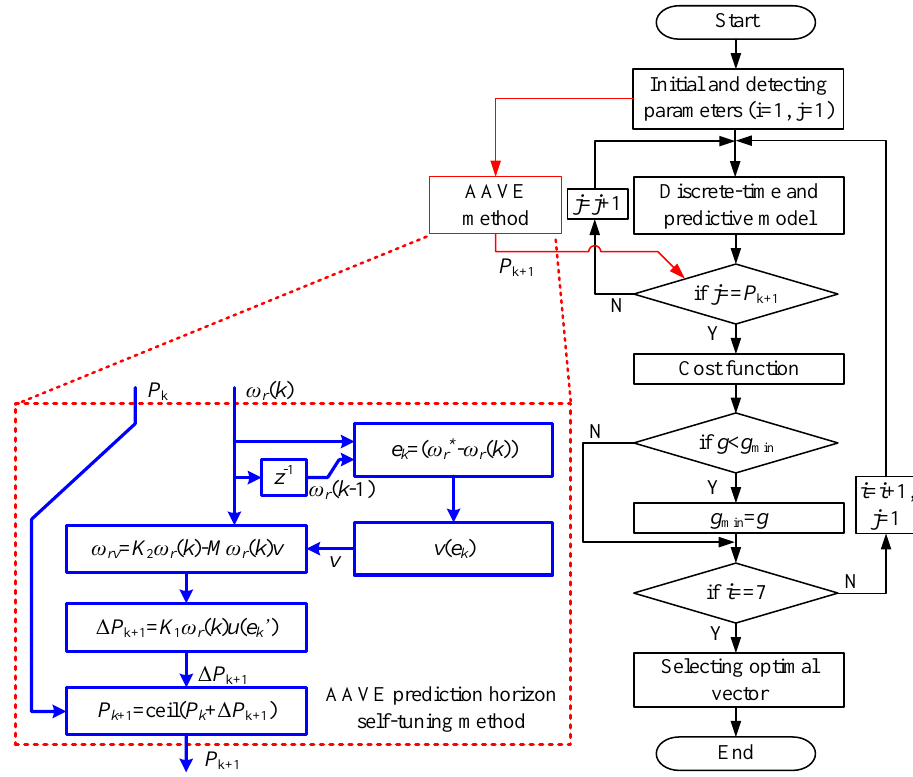
Figure 2. Flowchart of NMPSC with the proposed VVAE method.